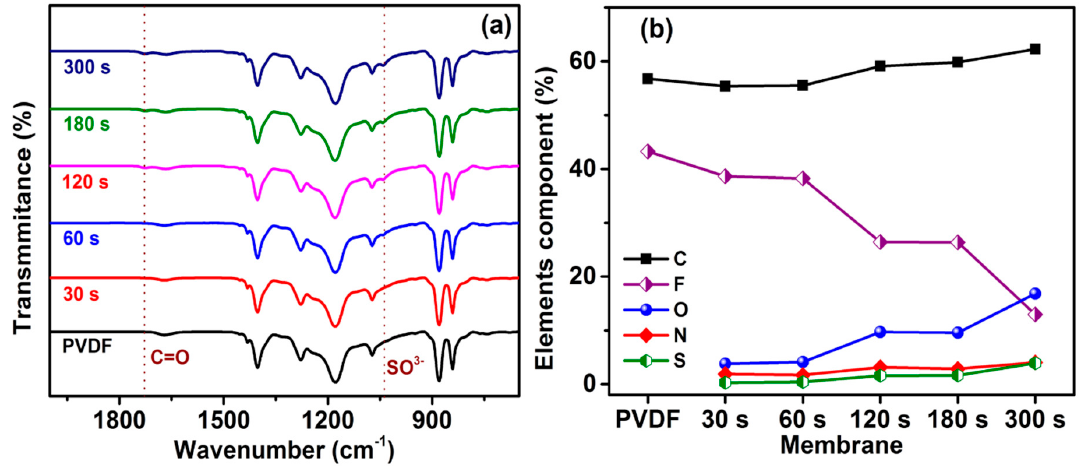
Figure 1. ( a ) Attenuated total reflectance Fourier transform infrared spectroscopy (ATR-FTIR) spectrum of PVDF-modified membrane. ( b ) X-ray photoelectron spectroscopy (XPS) spectrum analysis of the elemental ratio for the PVDF-modified membrane. Table 1. The XPS spectrum was evaluated using the elemental ratio of the unmodified PVDF and PSBMA-modified membrane.